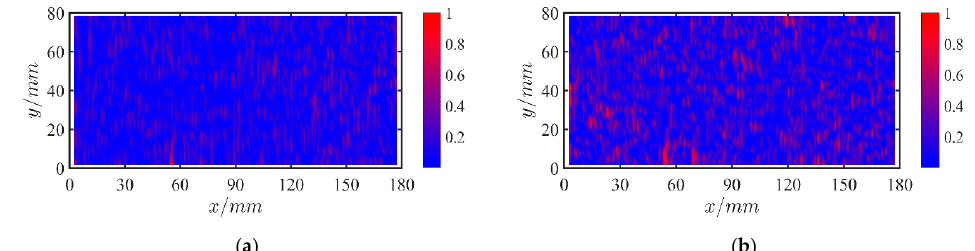
Figure 14. The RDI colored plot of the slight crack plate with the scanning rates of 0.05 Hz at the x direction and 10 Hz at the y direction. ( a ) The first torsion mode of 233.43 Hz. ( b ) The second torsion mode of 750.94 Hz.